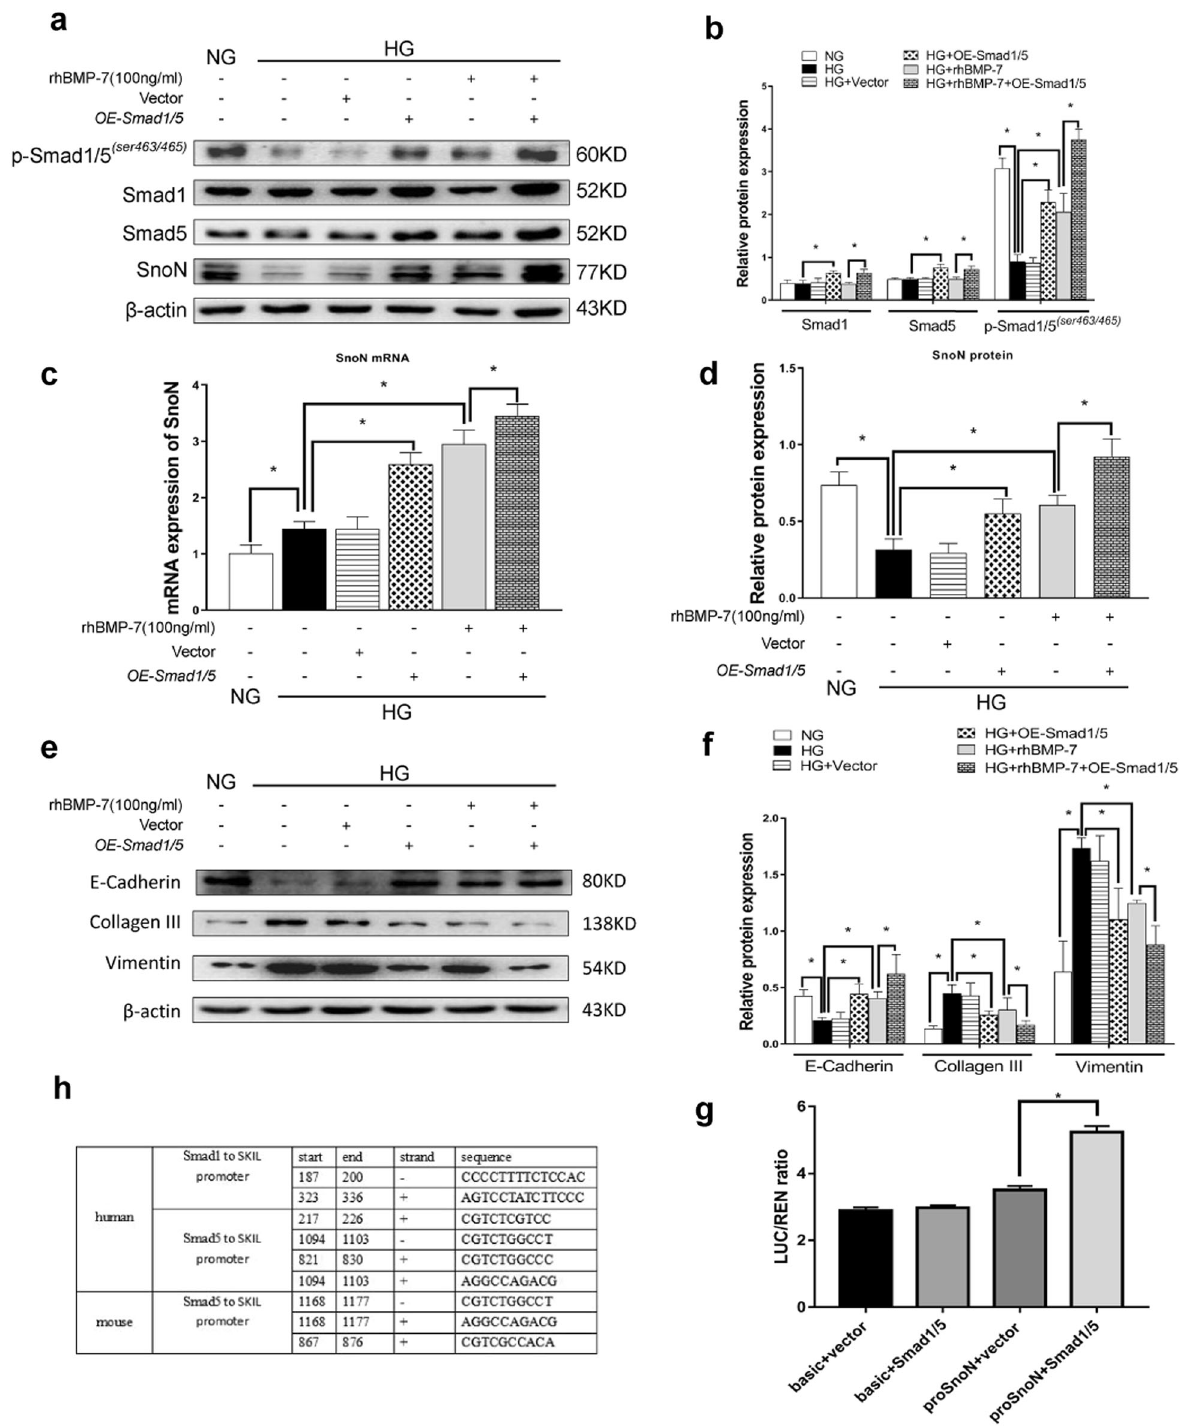
Fig. 7 Augment of Smad1/5 expression enhances BMP-7 induced SnoN protein and the renoprotection of BMP-7 in renal tubular interstitial fi brosis. Increase Smad1/5 in NRK-52E cells by transfection of Overexpression-Smad1/5(OE-Samd1/5) plasmid. Representative a Western blot and quantitative data were revealed the expression of b p-Smad1/5 (ser463/465) , Smad1, Smad5, and d SnoN in NRK-52E cells under different conditions. c Graphical presentations show the relative abundance of SnoN mRNA after normalization with β -actin mRNA analysised by RT-qPCR. Representative e Western blot and f quantitative data were revealed the expression of E-cadherin, Collagen-III, and Vimentin in NRK-52E cells under different conditions, * P < 0.05 ( n = 3). g The binding site between Smad1/5 and SKIL promoter predicted by Jaspar. h Luciferase detected the binding of Smad1/5 to SKIL promoter in HEK 293 T cells.